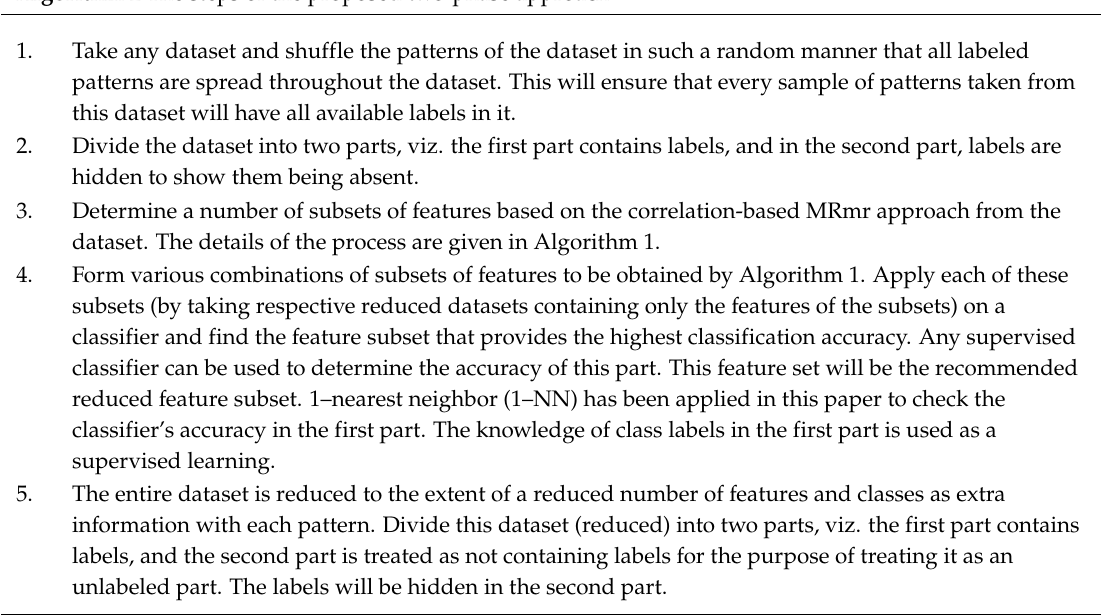
Algorithm 2 The steps of the proposed two-phase